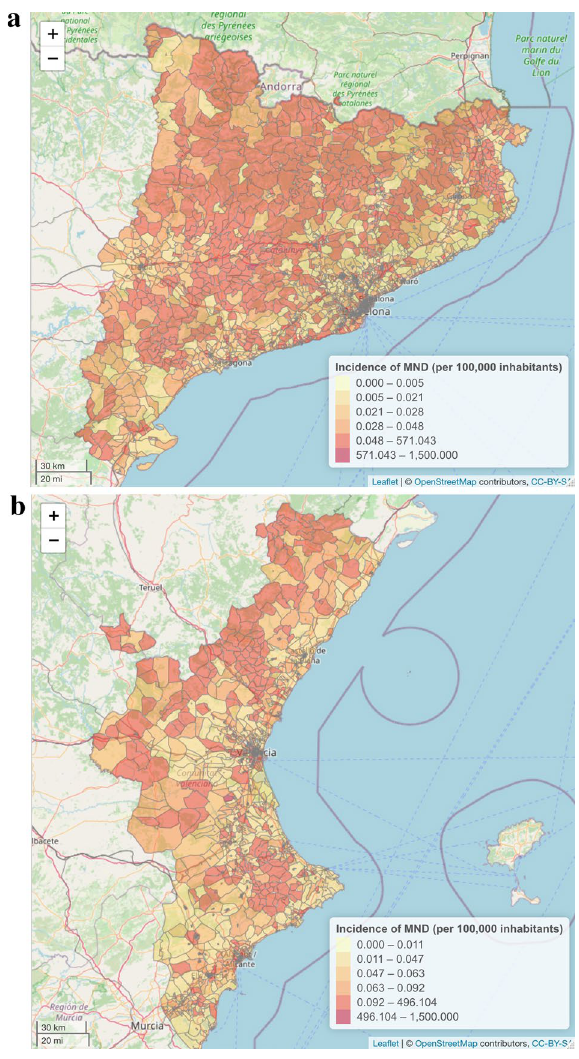
Figure 4. ( a ) Map of the estimated incidence per census tract across the study region (Catalonia). Own construction using the leaflet package 37 , version 2.0.3 [https ://CRAN.R-proje ct.org/packa ge=leafl et]. ( b ) Map of the estimated incidence per census tract across the study region (Valencia). Own construction using the leaflet package 37 , version 2.0.3 [https ://CRAN.R-proje ct.org/packa ge=leafl